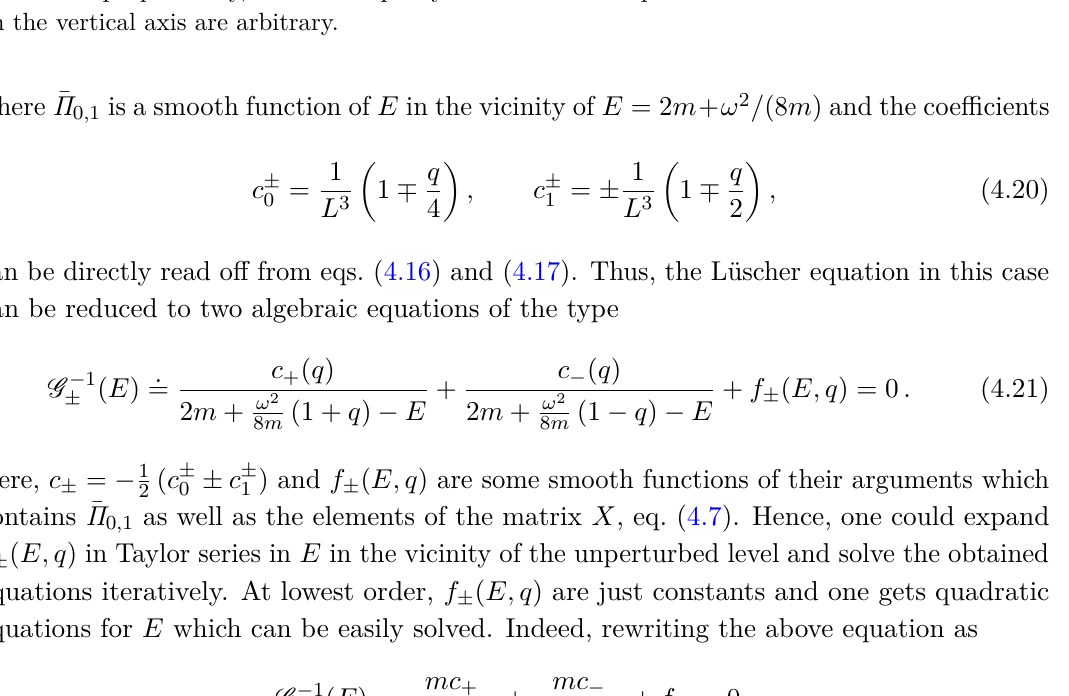
(“perturbative”) develops a 1